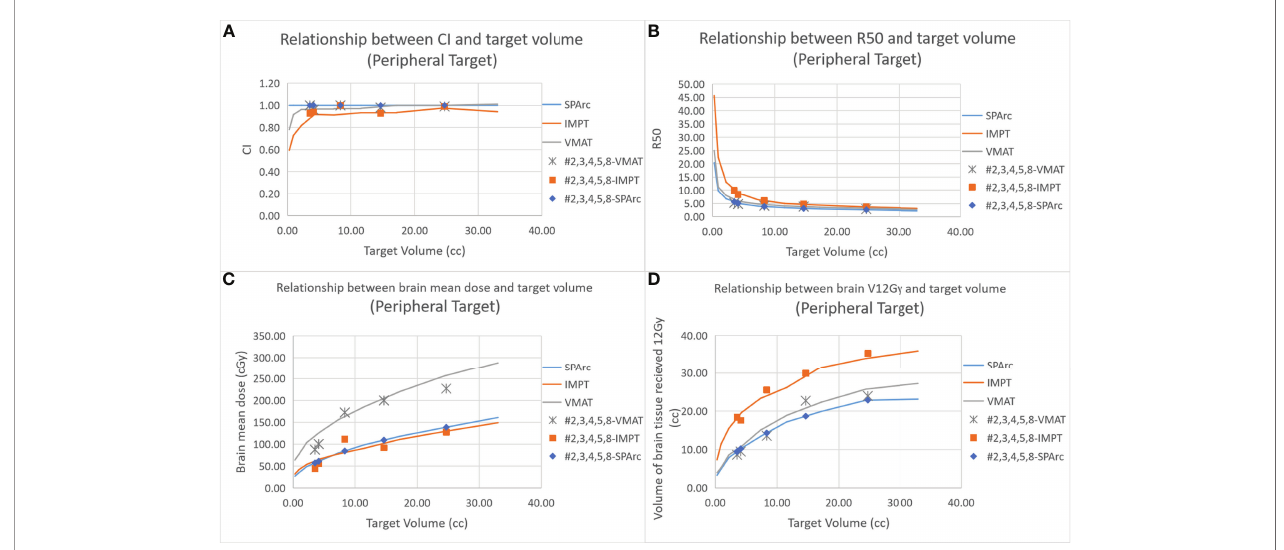
FIGURE 4 | Dosimetric metrics among three planning groups: SPArc, VMAT, and IMPT at peripheral region (A – D) of different target sizes. Dots, squares, and stars are the dosimetric metrics extracted from fi ve clinical validation cases normalized to SPArc plan ( Table 2 ).